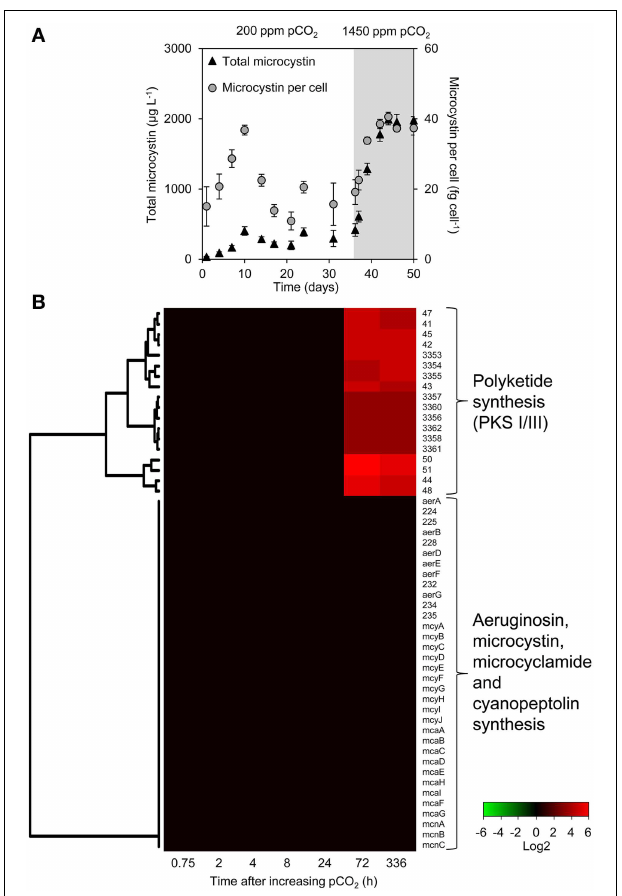
FIGURE 4 | Changes in microcystin concentration and gene expression of secondary metabolite genes. (A) Total microcystin concentration and microcystin content per cell, during the shift from low pCO 2 (200ppm, white area ) to high pCO 2 (1450ppm, shaded area ). Error bars indicate standard deviations ( n = 4 ). (B) Changes in expression of the secondary metabolite genes after the increase of pCO 2 to 1450ppm. Expression changes are quantified as log2 values. Red indicates significant upregulation and green significant downregulation; non-significant changes are in black. Hierarchical clustering was used to order the genes. The underlying data are presented in Supplementary Table